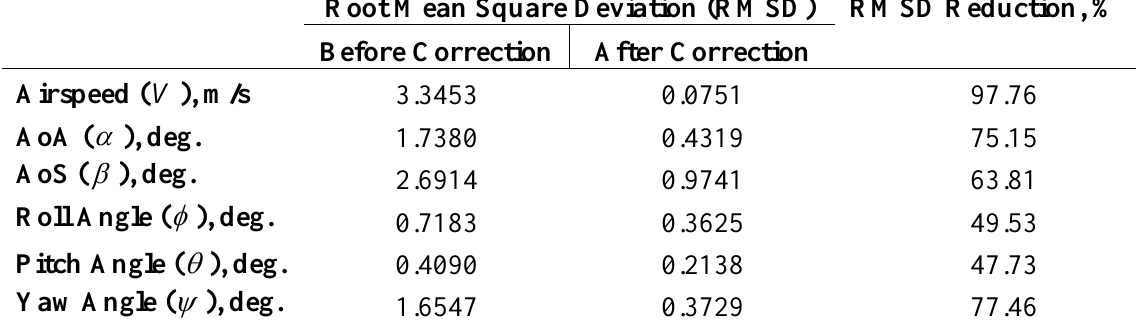
Table 1. Comparison of RMSD before and after correction of ft74srt02run01. Root Mean Square Deviation (RMSD) RMSD Reduction, % Before Correction After Correction Airspeed ( V ), m/s AoA ( ), deg. AoS ( ), deg. Roll Angle ( ), deg. Pitch Angle ( ), deg. Yaw Angle ( ), deg. Table 2. Comparison of RMSD before and after correction of ft74srt02run05. Root Mean Square Deviation (RMSD) RMSD Reduction, % Before Correction After Correction Airspeed ( V ), m/s AoA ( ), deg. AoS ( ), deg. Roll Angle ( ), deg. Pitch Angle ( ), deg. Yaw Angle ( ),